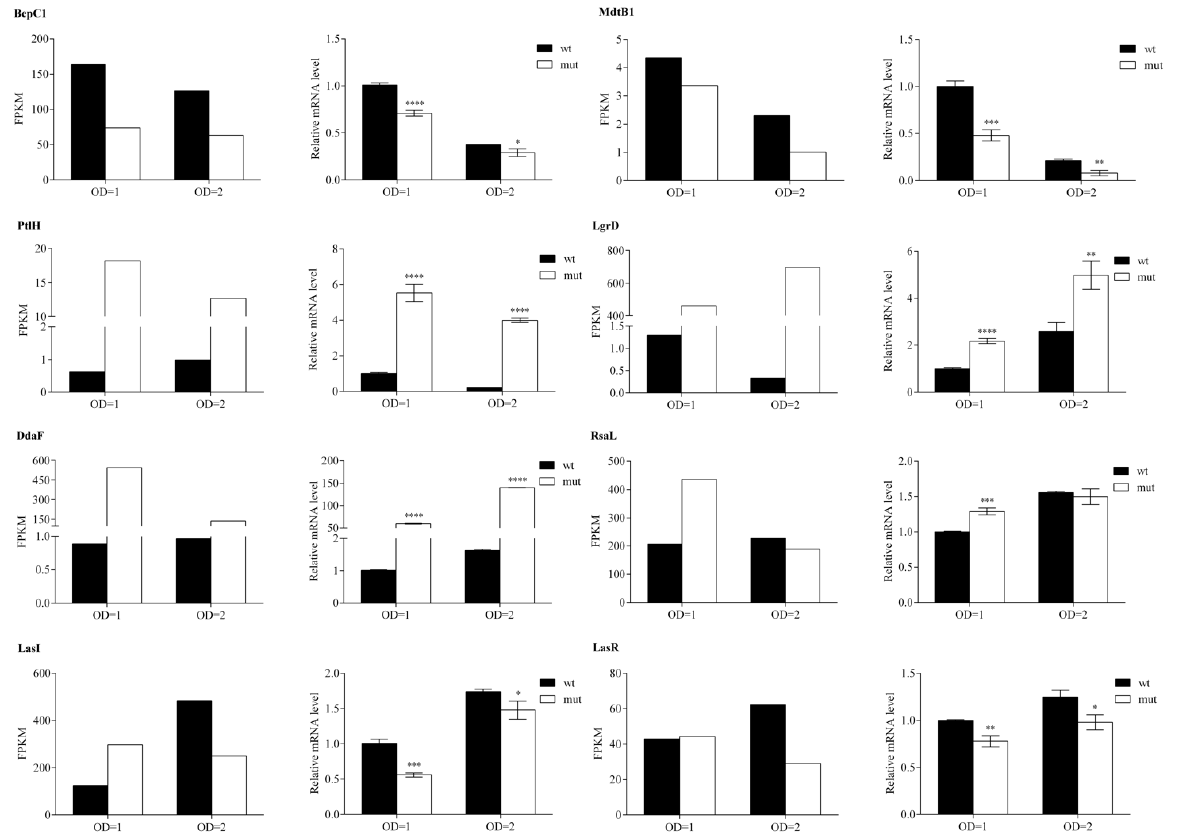
Figure 5. RT-qPCR based validation of RNA-seq analysis. Transcriptional level of eight selected genes in WCS358 wild type and Δ rclS mutant at two time points (OD = 1 and OD = 2) is represented as FPKM value (RNA-seq) and relative expression value normalized against those obtained for wild type in exponential growth phase (RT-qPCR). RT-qPCR data is represented as mean values ± stand- ard deviations for three biological replicates. Student’s t -test was employed to compare differences